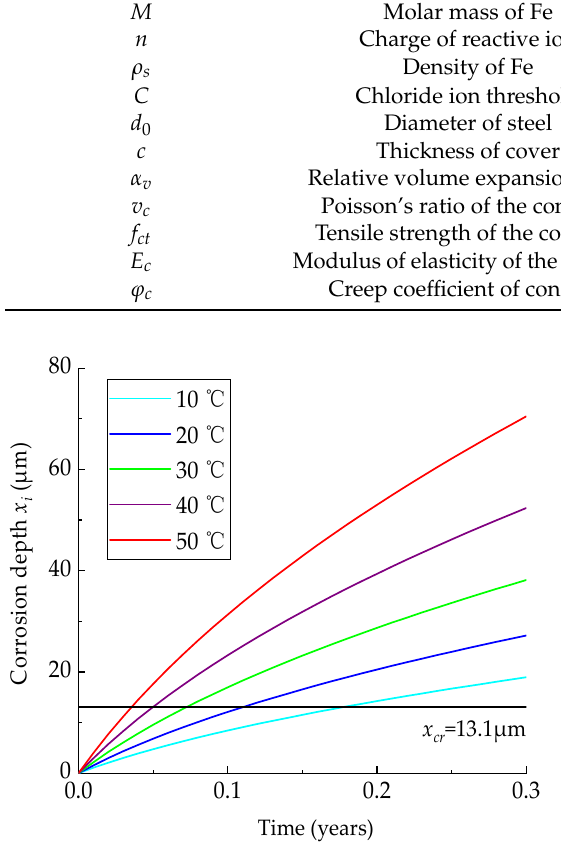
Figure 6. Corrosive depth x i in different temperatures.